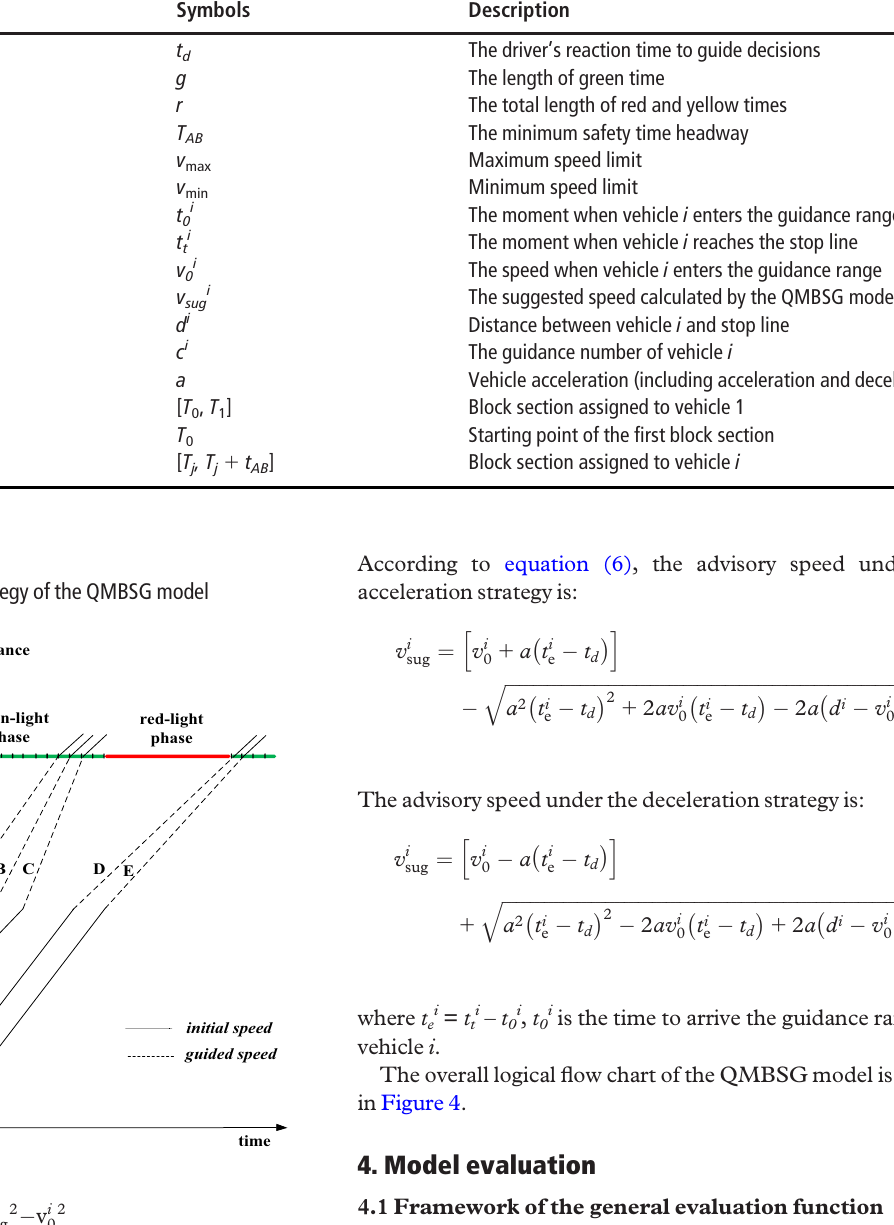
Table 1 Static and dynamic traf fi c state parameters Types Symbols